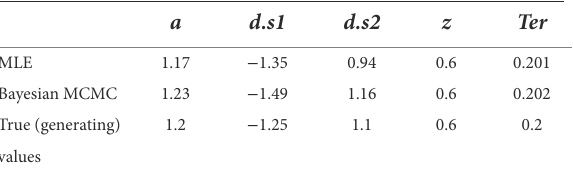
and/or show “hairy caterpillars” to document convergence (e.g., Figure 7C), and may plot posterior distributions to show that the parameter estimates are unimodal and (ideally) low in variance (e.g., Figure 7D). For MLE methods, optimization routines also been met for each file.